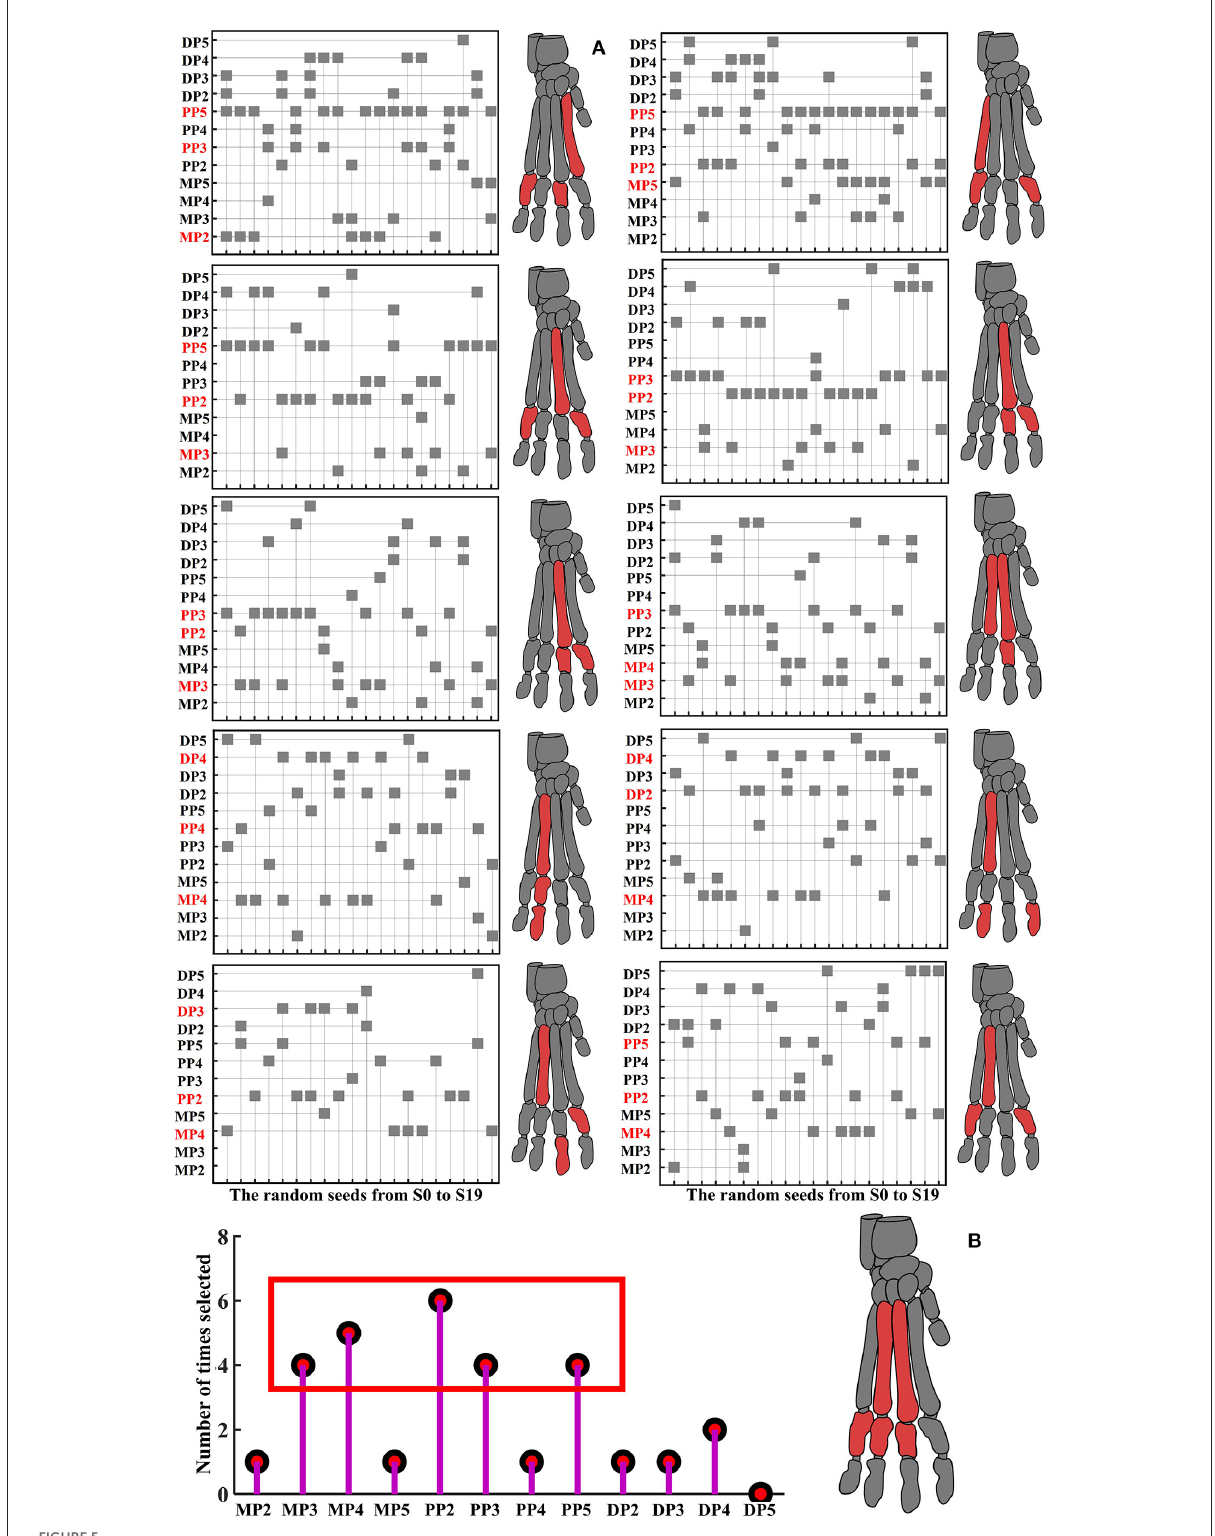
FIGURE5 Detailed results of features selected in each contrasting situations in each random seed. (A) The left side is the feature selection results based on the data of landing from 0.8 to 1.0m, and the right side is the feature selection results based on the data of landing from 1.0 to 1.2m. From top to bottom are the results based on the data of stress value corresponding to all nodes, the data of the first 2,000 nodes with the highest stress